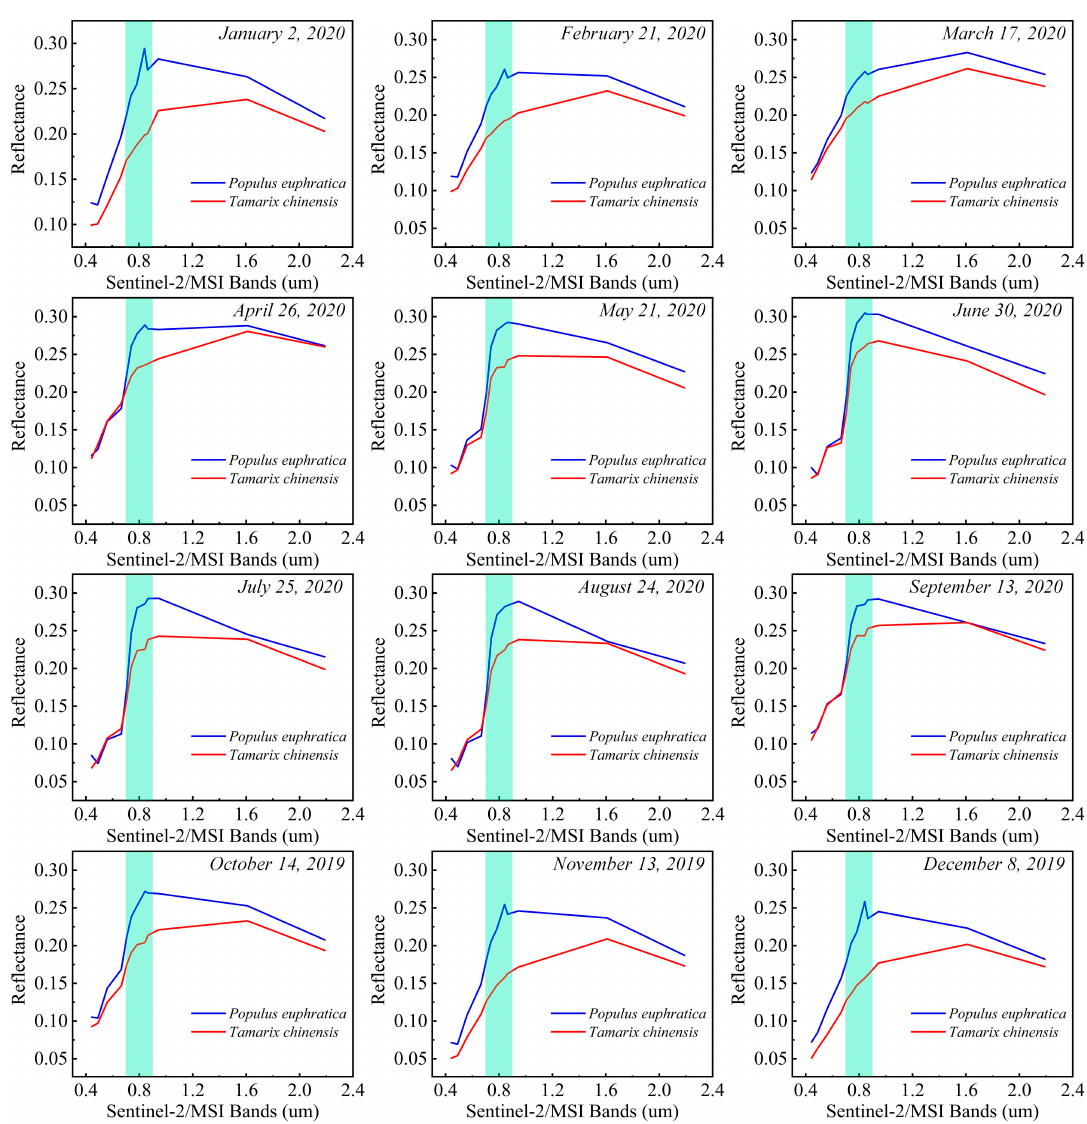
Figure 4. Spectral reflectance curves for Populus euphratica and Tamarix chinensis obtained from monthly Sentinel-2 images.